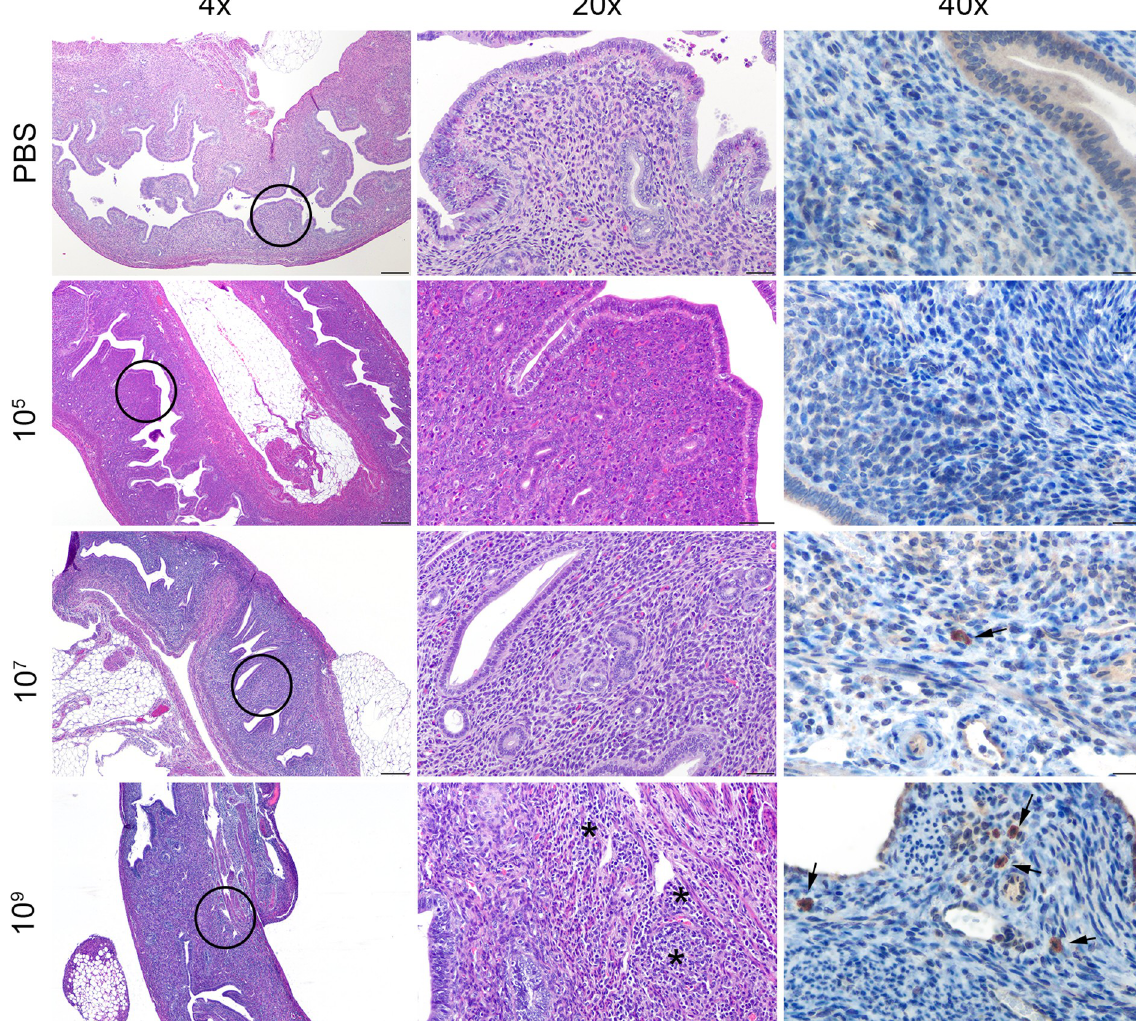
Fig 6. Histopathology of the uterus in mice infected with B . canis . Representative images of histopathology and immunohistochemistry of the uterus of mice infected intraperitoneally with PBS (top row) or B . canis RM6/66 at a low dose (10 5 , second row), mid-range dose (10 7 , third row), or high dose (10 9 , bottom row) at 2-weeks post-infection. The black circles in the left panel indicate the section highlighted to higher magnification in the middle panel. Infection with B . canis resulted in histiocytic, neutrophilic, and lymphocytic peritonitis and metritis ( � ). Brucella antigen was detected within the cytoplasm of macrophages in the outer myometrium by immunohistochemistry (arrows). Magnification 4x (left column, HE, scale bar = 100 μ m), 20x (middle column, HE, scale bar = 50 μ m), 40x (right column, IHC with DAB chromagen, bar = 20 μ